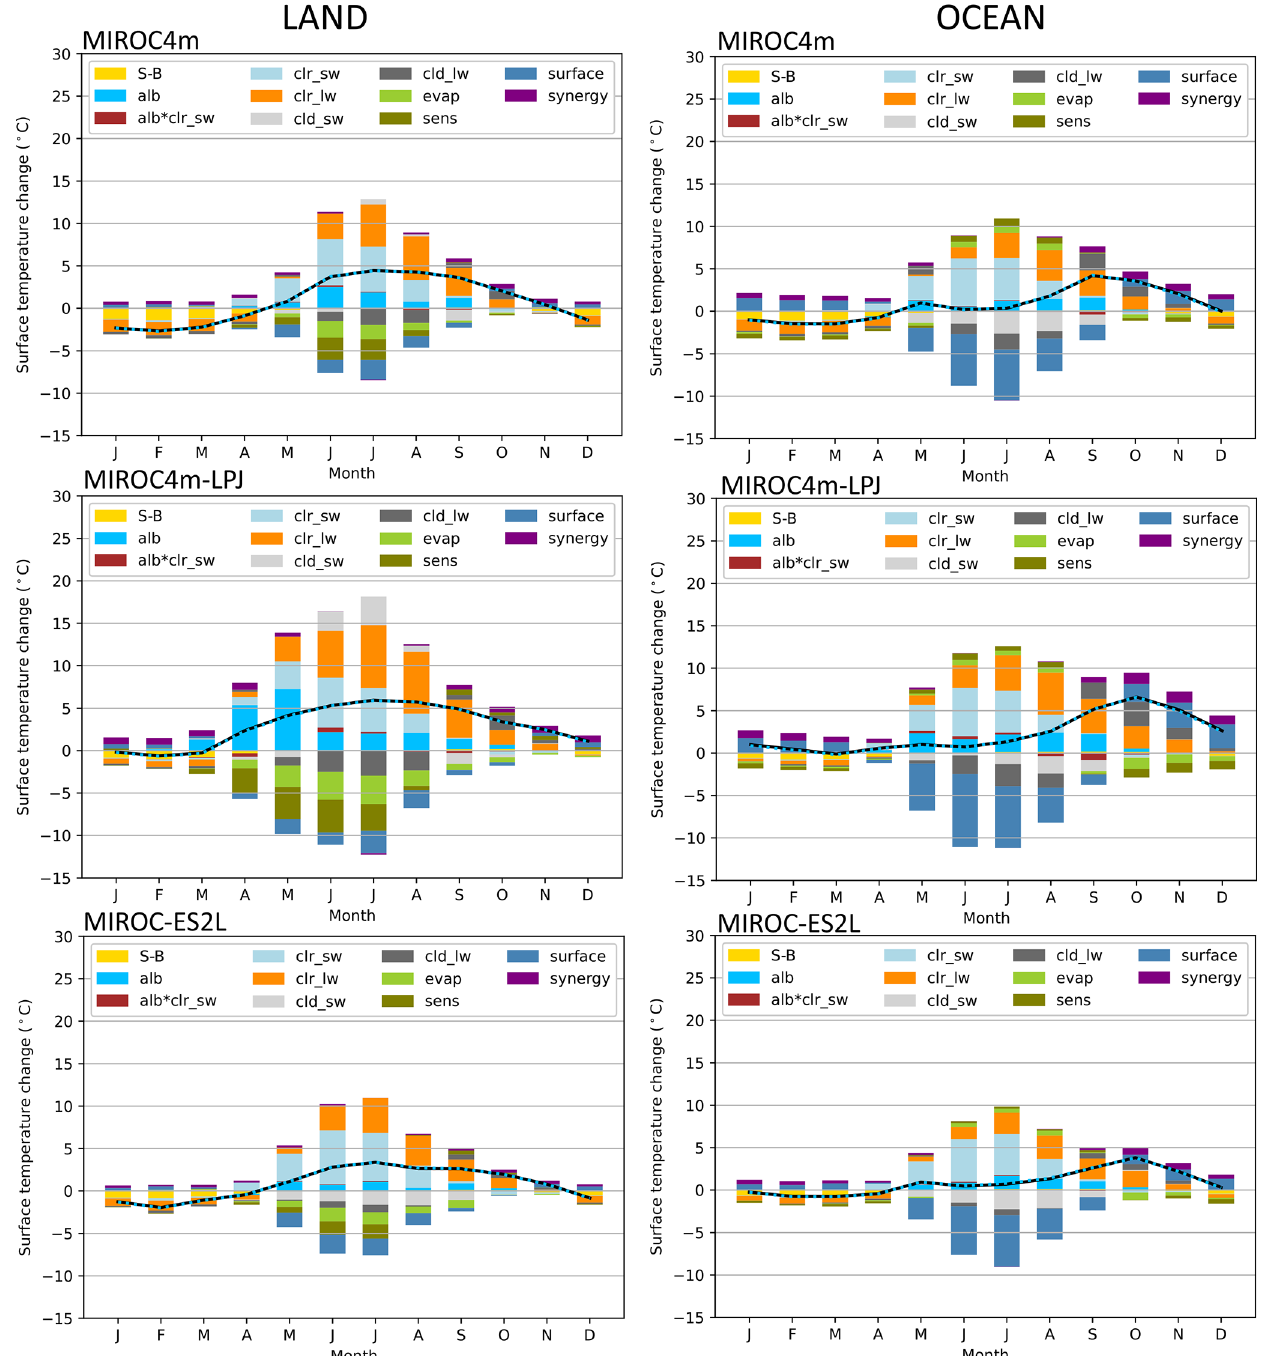
Figure 16. Simulated and diagnosed surface temperature changes (K) in 127k from PI for the land and the ocean (north of 60 ◦ N). The solid black polygonal lines denote simulated changes, and dashed blue lines denote the sum of the diagnosed partial changes; the two lines are superimposed. See Table 3 for the interpretation of each